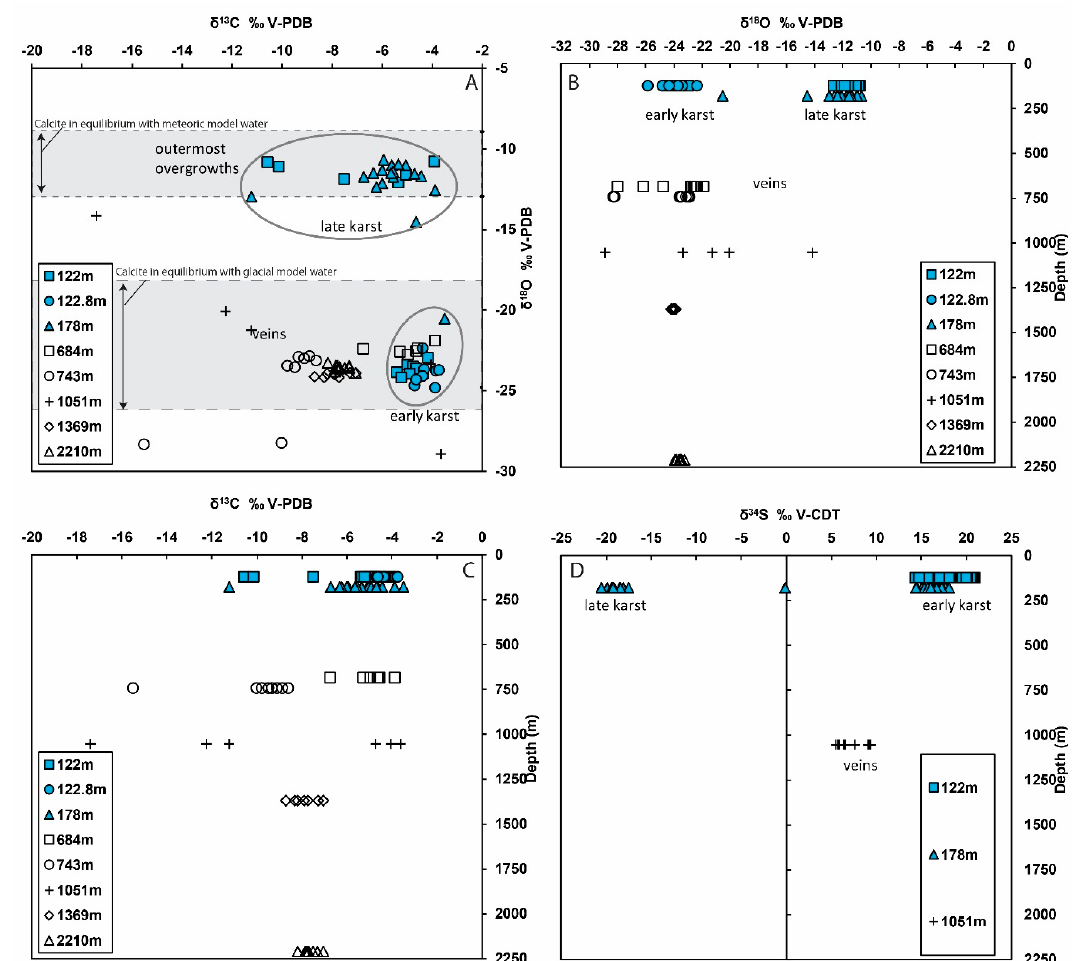
Figure 3. Stable isotope scatter and depth plots, divided into micro-karst samples (blue symbols) and vein samples (transparent symbols and black crosses). ( A ) δ 18 O calcite vs. δ 18 O calcite , with marker for the different micro-karst groups (spheres), as well as spans of calculated values for hypothetical calcite precipitated from ambient meteoric or glacial water. For this comparison, temperature dependent fractionation factors for calcite precipitation at ambient temperatures are used for δ 18 O [22]. See text for details of temperatures and isotope spans of the model waters. ( B ) δ 18 O calcite vs. depth. ( C ) δ 13 C calcite vs. depth. ( D ) δ 34 S pyrite vs. depth.